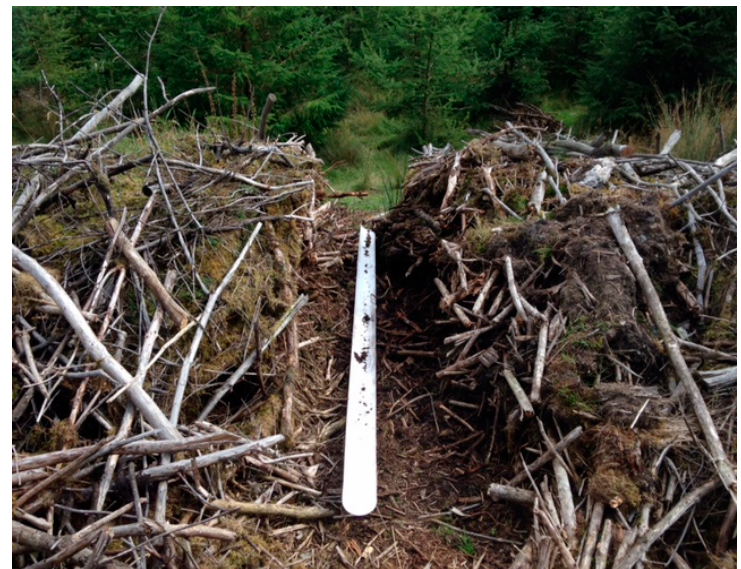
Figure 1. Windrowed woody debris (WD) visible on the clearfelled and reforested stand on the brow of the hill at Ballinastoe forest ( top ). Sampling involved cutting a 50 cm-wide band across a windrow directly above where lysimeters had been inserted a year previously ( bottom ). The debris removed was sorted into various categories and decay classes.